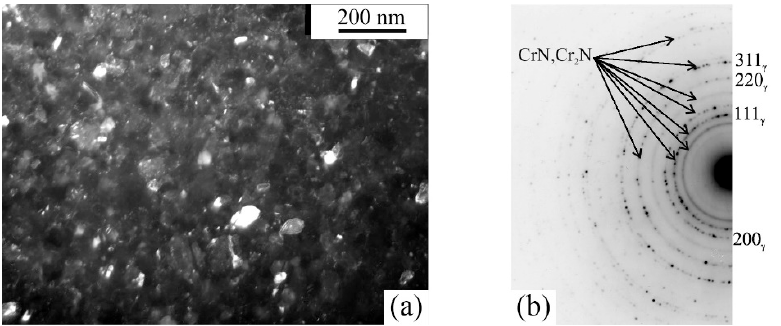
taken in the combined reflection ((111) γ + CrN, Cr 2 N); ( b ) SAED pattern.